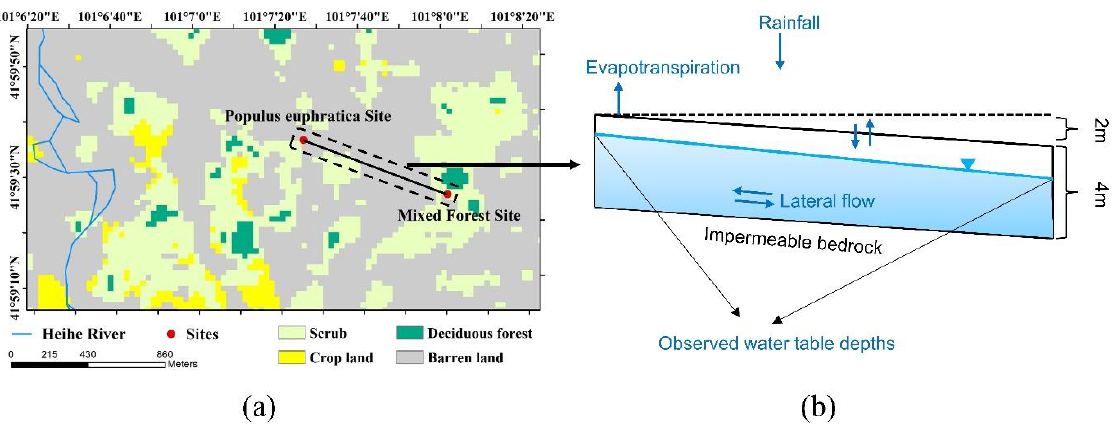
Figure 5. Configurations of the BJH case: ( a ) Location of the 2D transect; ( b ) Simulation setup.